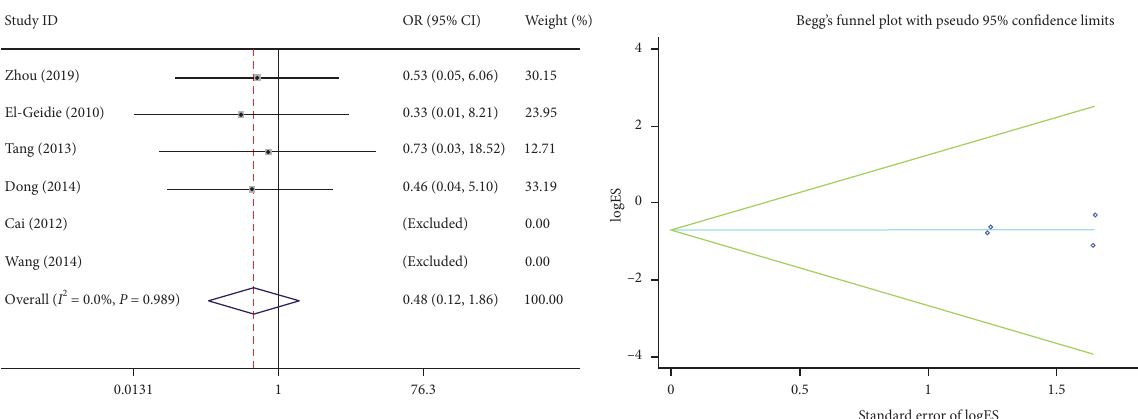
Study ID Weight (%)OR (95% CI) Begg’s funnel plot with pseudo 95% confidence limits